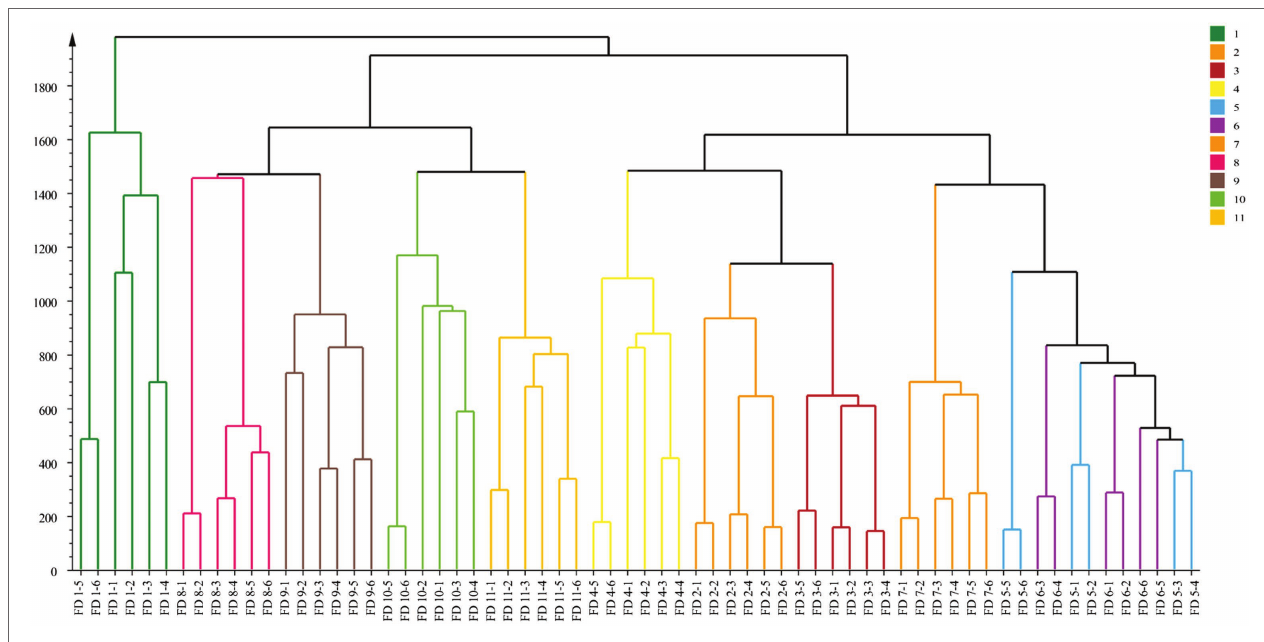
FIGURE 5 | Cluster analysis of CWT at different growth stage in negative ion